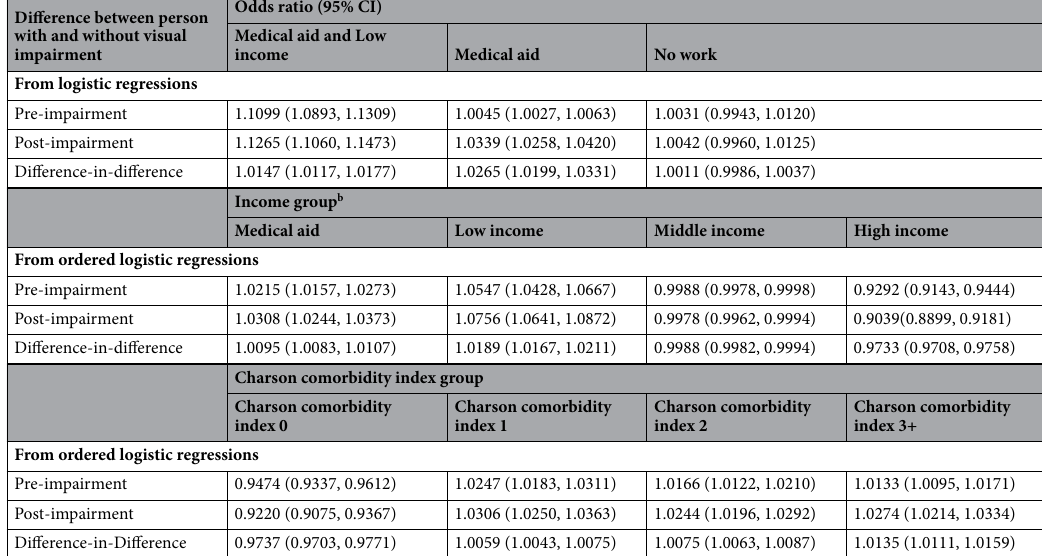
Table 2. The estimated effect of visual impairment on socioeconomic and health status (N = 751,812). a * p < 0.10, ** p < 0.05, *** p < 0.01. b Medical aid, Low income (1st to 4th deciles), Middle income (5th to 8th deciles), High income (9th to 10th